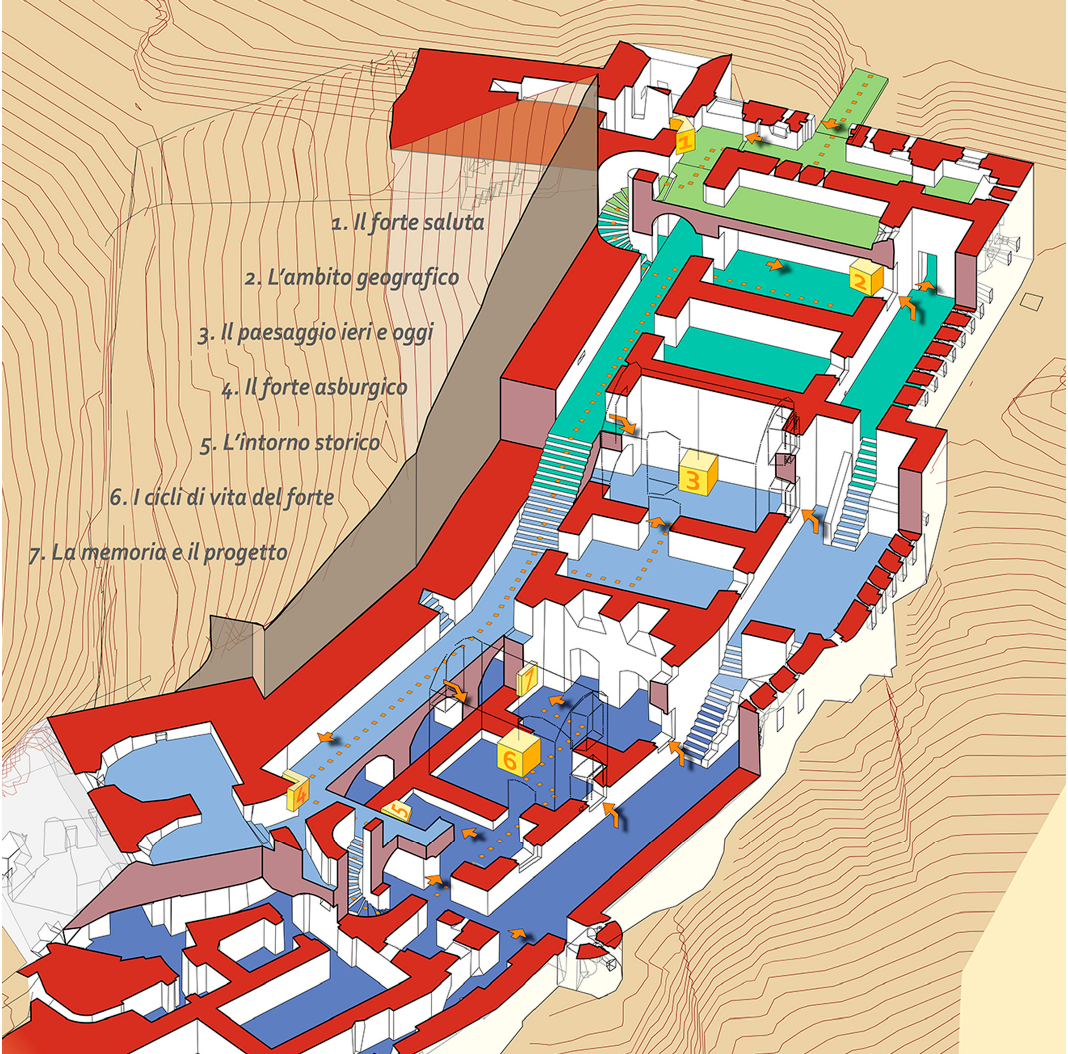
Figure 2. The multimedia tour of Forte